Question: Write a caption explaining this figure to a reader.
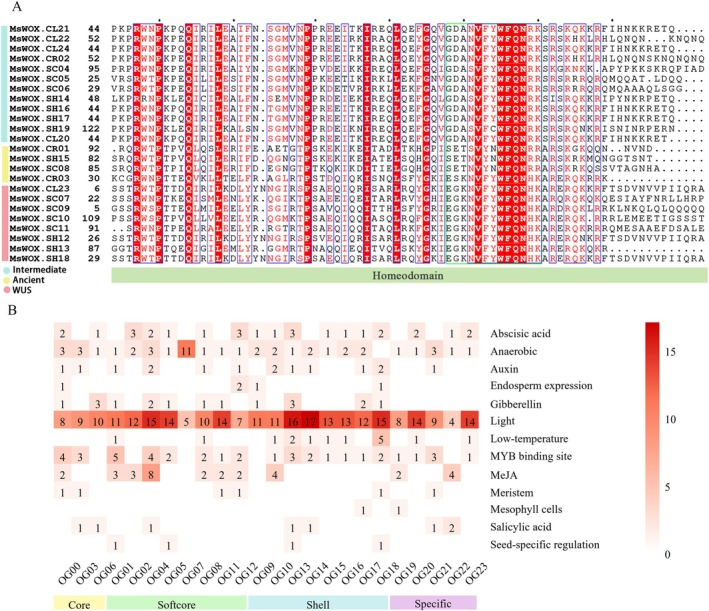
Answer: (A) Multiple sequence alignment of representative genes from different OGGs in alfalfa. (B) Average number of cis‐acting regulatory elements in representative genes from each OGG.